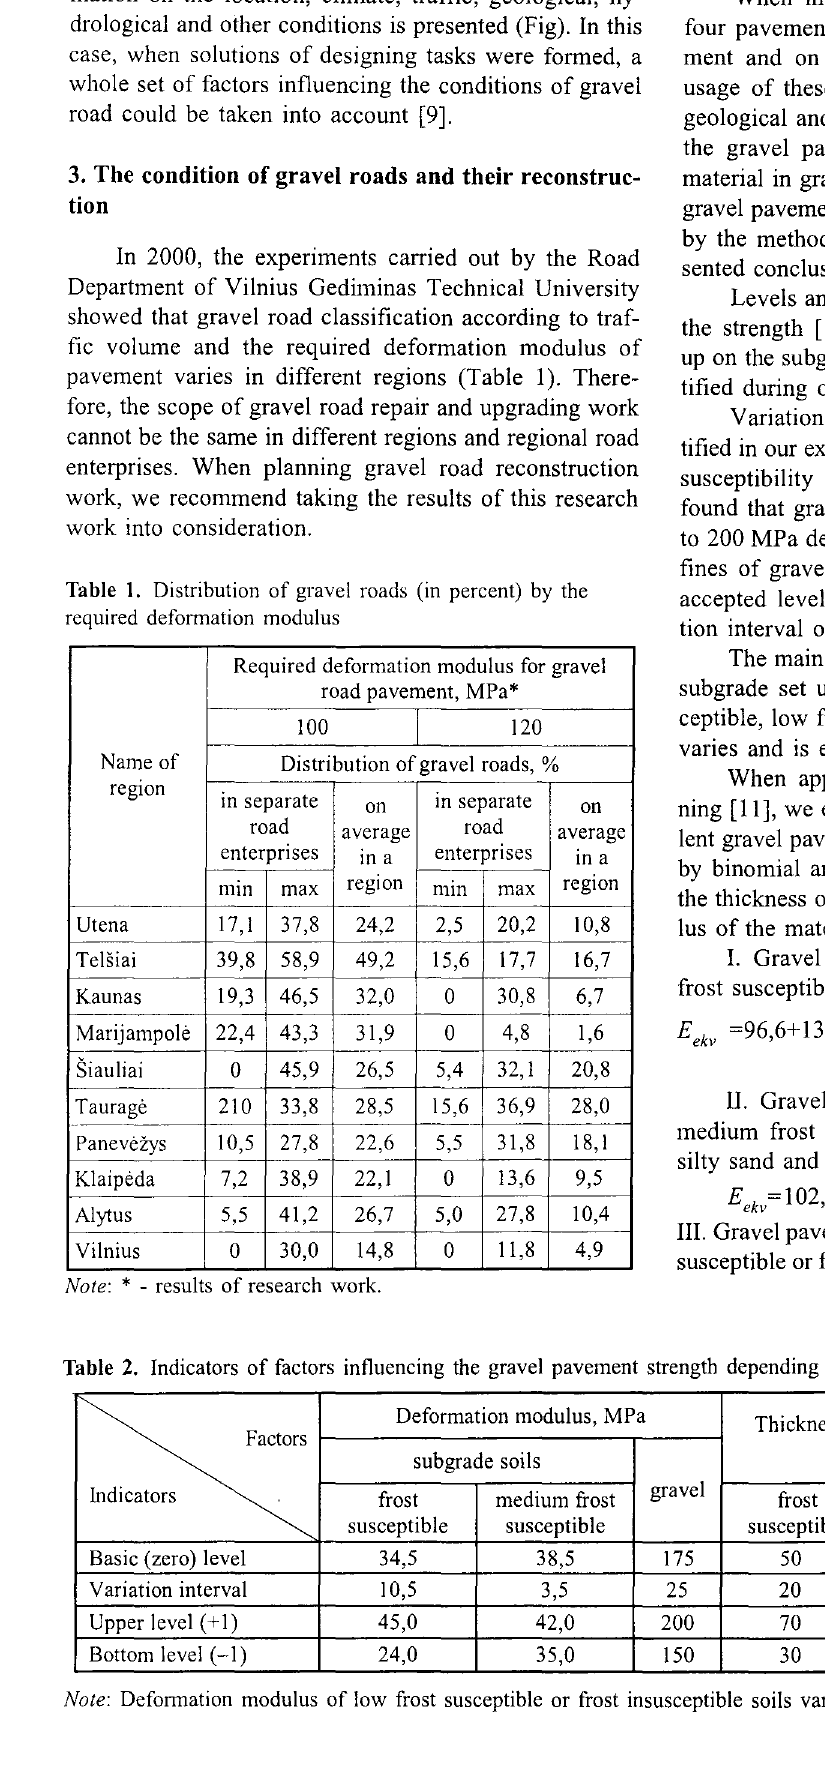
Table 2. Indicators of factors influencing the gravel pavement strength depending on the frost susceptibility of subgrade